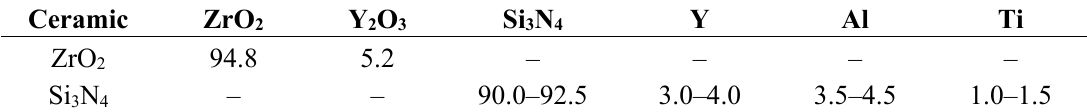
Table A3. Chemical composition (wt. %) of ceramic balls.